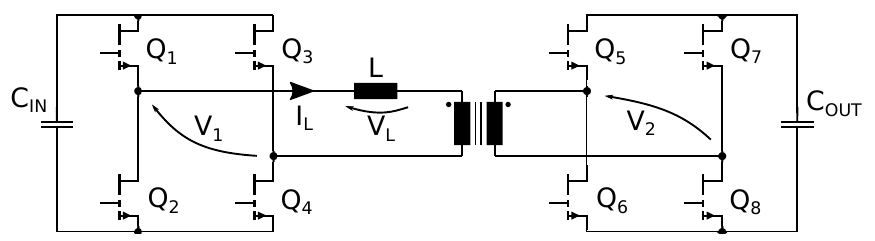
Figure 1. DAB converter